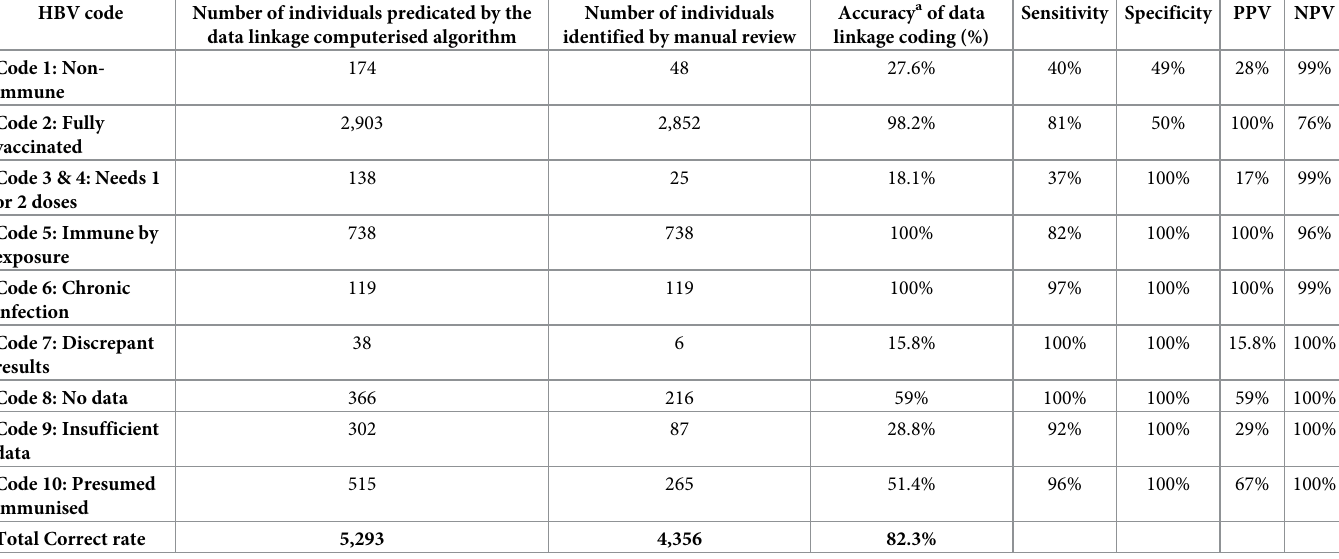
Table 4. HBV code allocated by data linking and computerised algorithim process for the Aboriginal population in five communities, compared to code determined by clinician’s manual review of the clinical information in three patient databases. HBV code Number of individuals predicated by the Number of individuals Accuracy a of data Sensitivity Specificity PPV linkage coding (%) data linkage computerised algorithm identified by manual review